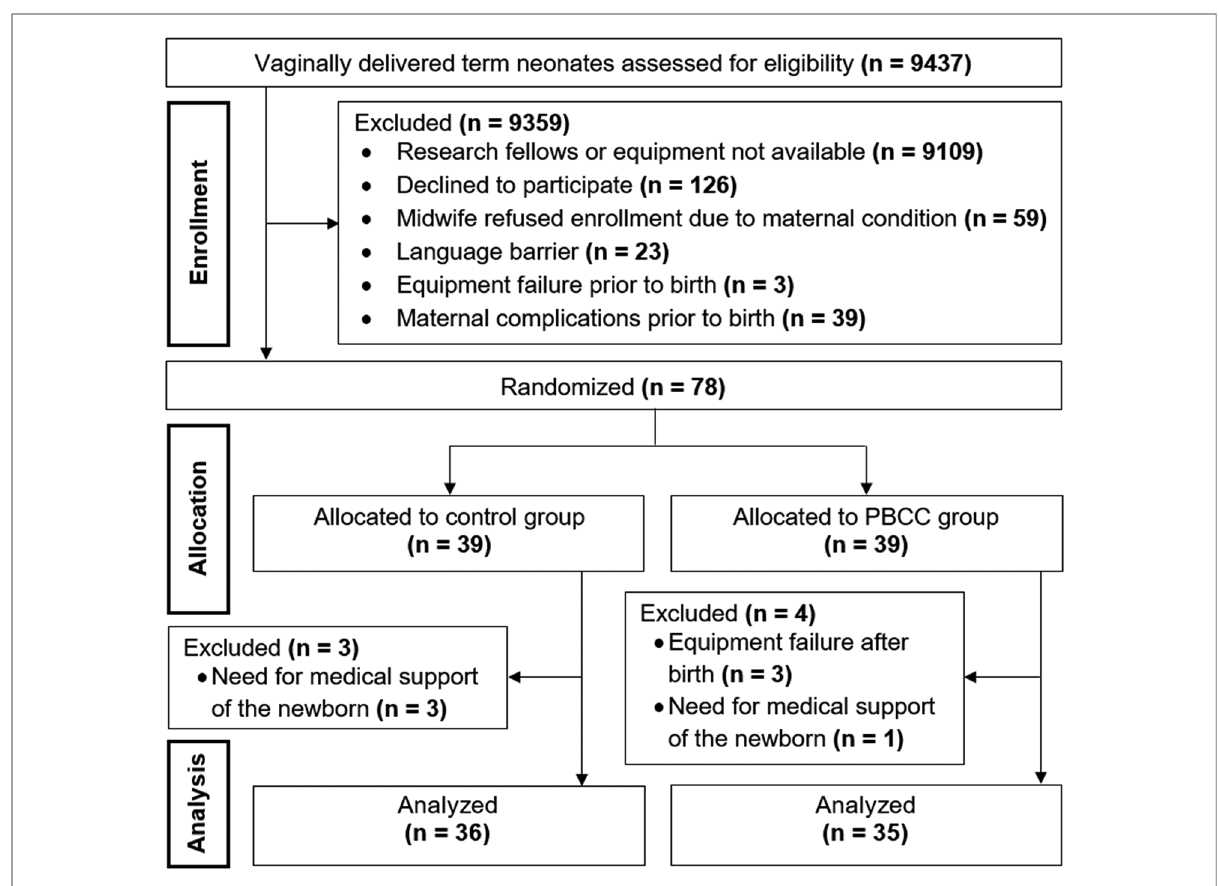
FIGURE 1 CONSORT diagram demonstrating enrollment, allocation and data analysis. PBCC, physiological-based cord